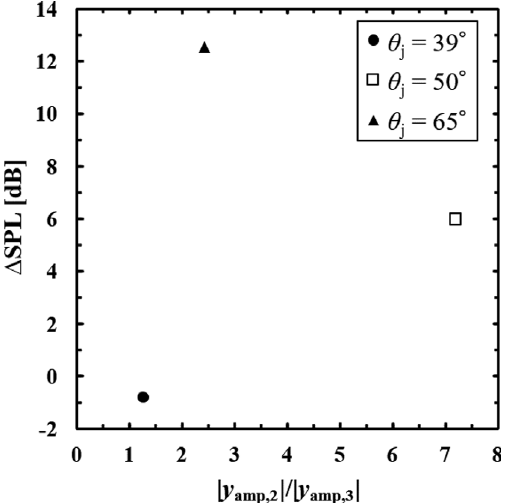
Figure 19. Relation between relative jet amplitude of second to third mode at x j / h = 5 and differential SPL of second to third harmonic. ( y j,e = 0, l / h = 5.6, Q = 16